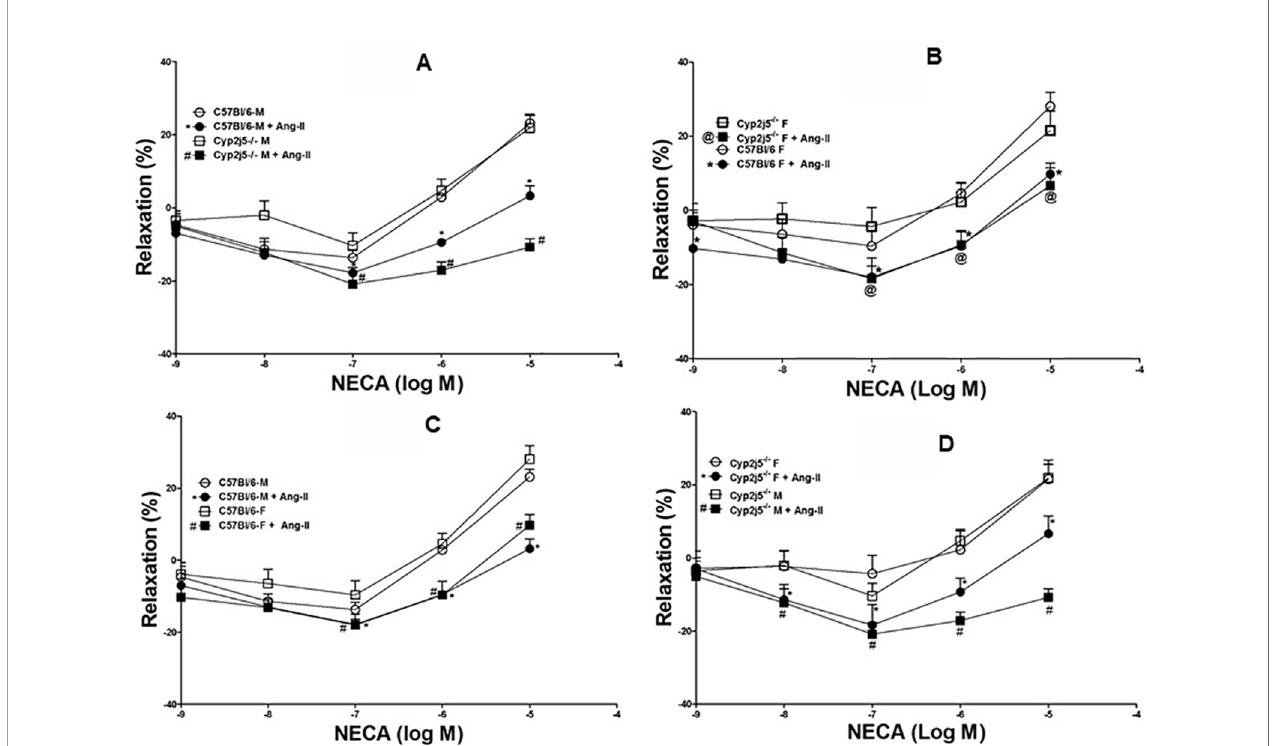
FIGURE 5 | (A) Effect of angiotensin II (Ang-II) (10 − 6 M) on 5'-N-ethylcarboxamidoadenosine (NECA)-induced concentration dependent vascular response in aortic rings of C57Bl/6 (M) and Cyp2j5 − / − (M) mice. * P < 0.05 between non-treated C57Bl/6 (M) vs . Ang-II treated C57Bl/6 (M) mice, P > 0.05 between non-treated C57Bl/ 6 (M) vs . non-treated Cyp2j5 − / − (M) mice, # P < 0.05 between non-treated C57Bl/6 (M) vs . Ang-II-treated Cyp2j5 − / − (M) mice. # P < 0.05 between non-treated Cyp2j5 − / − (M) and Ang-II treated Cyp2j5 − / − (M) mice and between Ang-II treated Cyp2j5 − / − (M) vs . Ang-II treated C57Bl/6 (M) mice ( #* P < 0.05). Values expressed as means ± SE. n = eight per group (5A). (B) Ang-II effect was tested on NECA-induced response in C57Bl/6 (F) and Cyp2j5 − / − (F) mouse aortas. * P < 0.05 between non-treated C57Bl/6 (F) vs . Ang-II treated C57Bl/6 (F) mice, P > 0.05 between non-treated C57Bl/6 (F) vs . non-treated Cyp2j5 − / − (F) mice, @ P < 0.05 between non- treated C57Bl/6 (F) vs . Ang-II-treated Cyp2j5 − / − (F) mice. @ P < 0.05 between non-treated Cyp2j5 − / − (F) and Ang-II treated Cyp2j5 − / − (F) mice and between Ang-II treated Cyp2j5 − / − (F) vs . Ang-II treated C57Bl/6 (F) mice ( @* P > 0.05). Values expressed as means ± SE. n = eight per group (5B). (C) NECA-induced concentration dependent vascular response was tested with Ang-II (10 − 6 M) in aortic rings of C57Bl/6 (M) and C57Bl/6 (F) mice. * P < 0.05 between non-treated C57Bl/6 (M) vs . Ang-II treated C57Bl/6 (M) mice, P > 0.05 between non-treated C57Bl/6 (M) vs . non-treated C57Bl/6 (F) mice, # P < 0.05 between non-treated C57Bl/6 (F) vs . Ang-II- treated C57Bl/6 (F) mice. @ P < 0.05 between non-treated C57Bl/6 (F) and Ang-II treated C57Bl/6 (F) mice and between Ang-II treated C57Bl/6 (F) vs . Ang-II treated C57Bl/6 (M) mice ( #* P > 0.05). Values expressed as means ± SE. n = eight per group (C) . (D) Effects of Ang-II on NECA-induced concentration dependent vascular response in aortic rings of Cy2j5 − / − (M) and Cy2j5 − / − (F) mice. # P < 0.05 between non-treated Cy2j5 − / − (M) vs . Ang-II treated Cy2j5 − / − (M) mice, P > 0.05 between non-treated Cy2j5 − / − (M) vs . non-treated Cy2j5 − / − (F) mice, * P < 0.05 between non-treated Cy2j5 − / − (F) vs . Ang-II-treated Cy2j5 − / − (F) mice. # P < 0.05 between non- treated Cy2j5 − / − (M) and Ang-II treated Cy2j5 − / − (F) mice, and between Ang-II treated Cy2j5 − / − (F) vs . Ang-II treated Cy2j5 − / − (M) mice ( # * P < 0.05). Values expressed as means ± SE. n = eight per group